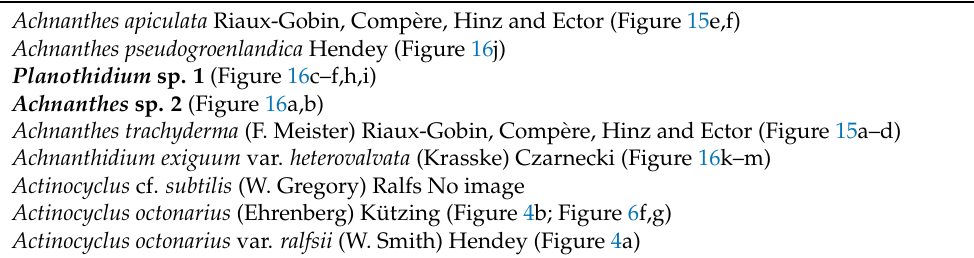
Table 1. Floristic list of epiphytic diatoms (Bacillariophyceae) found on thalli of rhodophytes and phaeophytes collected at Revillagigedo Islands, Mexico, that constitute new records for the archipelago. Bold = potential new records for the Mexican Pacific coast. * Corrected synonymies from